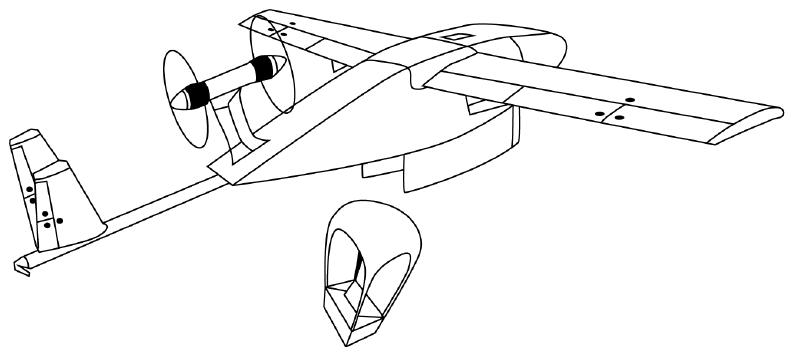
Figure 12. Illustration of the Zipline Flyer